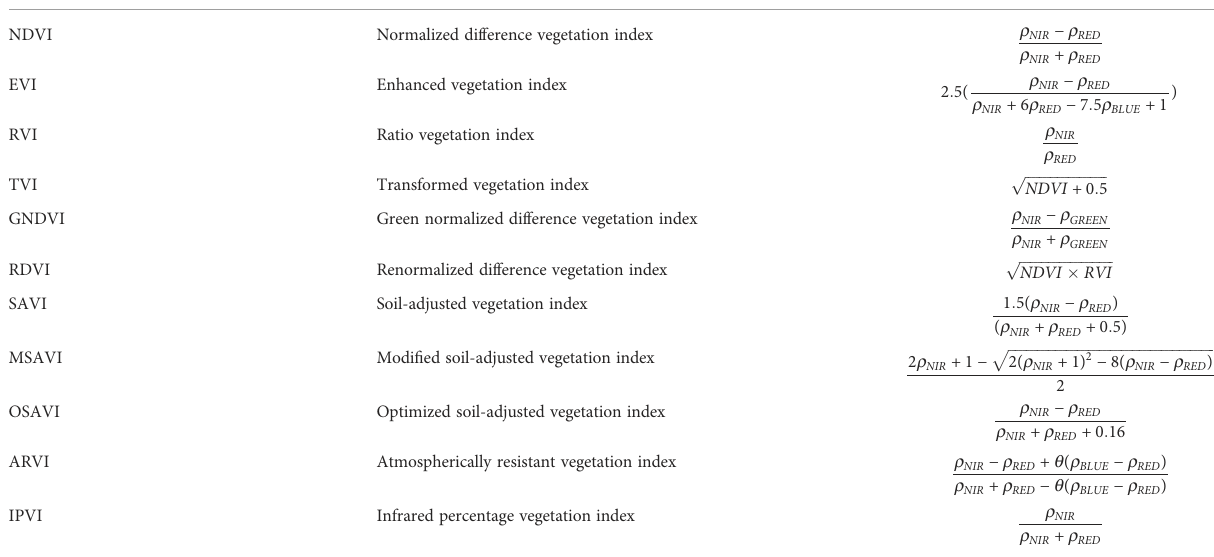
TABLE 1 Vegetation index formula. Vegetation index